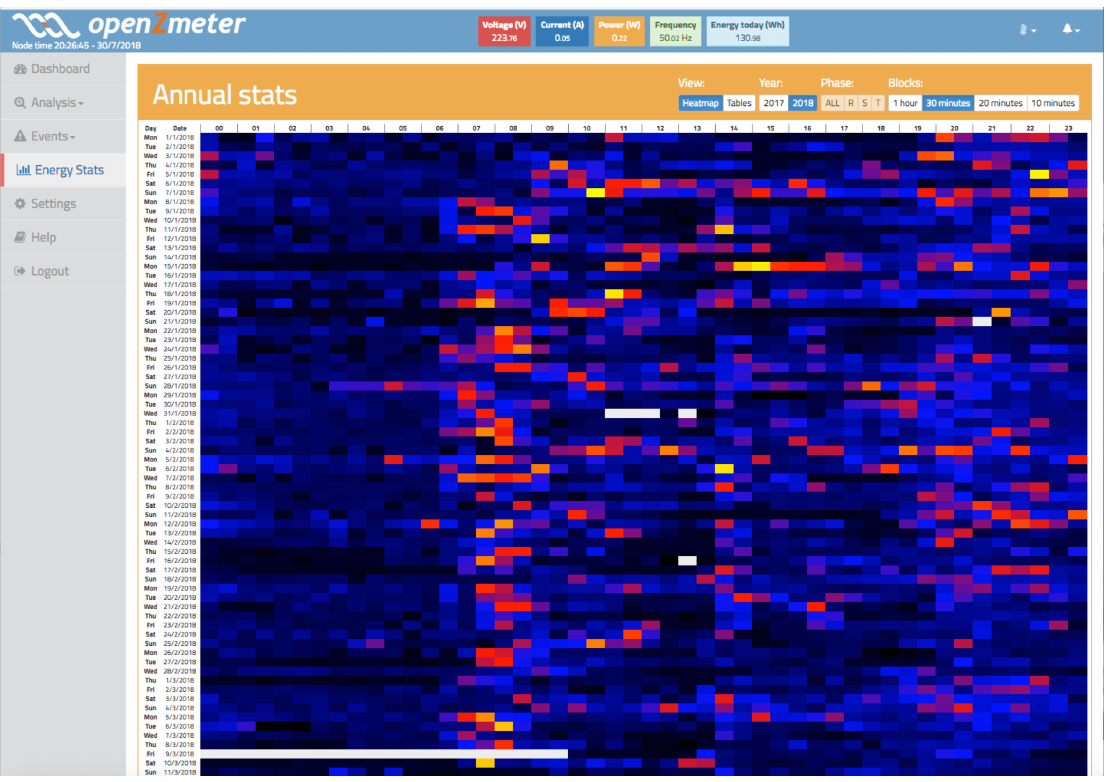
Figure 17. Active energy heat view of